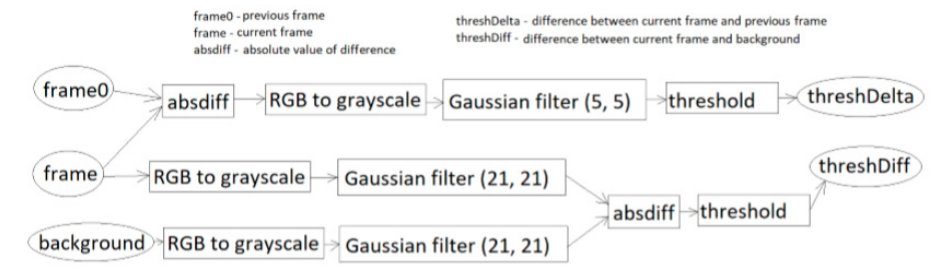
Figure 10. The use of Gaussian filters.